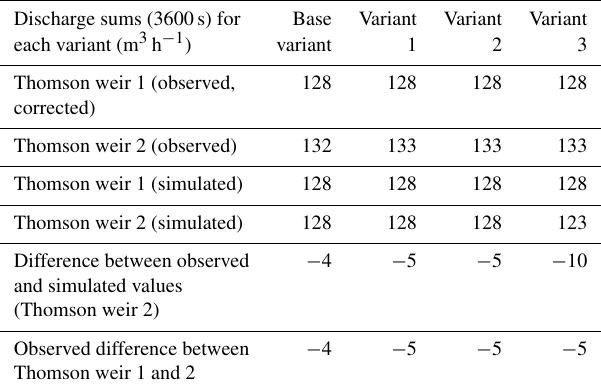
Table 1. Average observed and simulated discharge sums (m 3 h − 1 ) at both Thomson weirs for all simulation variants. For variant V1 and V2 discharge sums with subsequent adjustment of riparian Strickler coefficients are